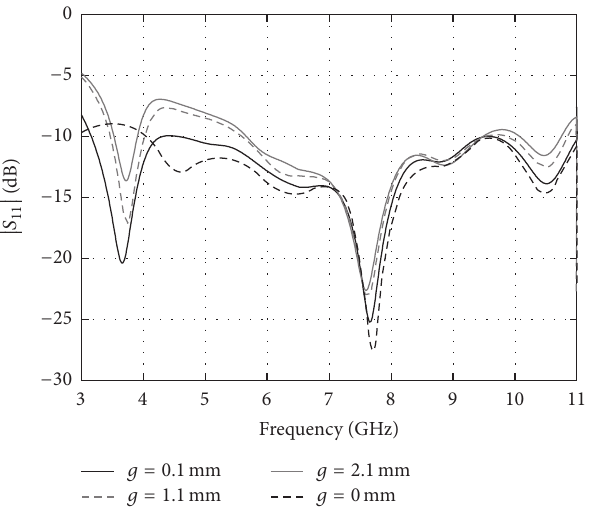
Figure 2: Effect of the outer side of the radiating patch 𝐿 1 on the reflection coefficient.